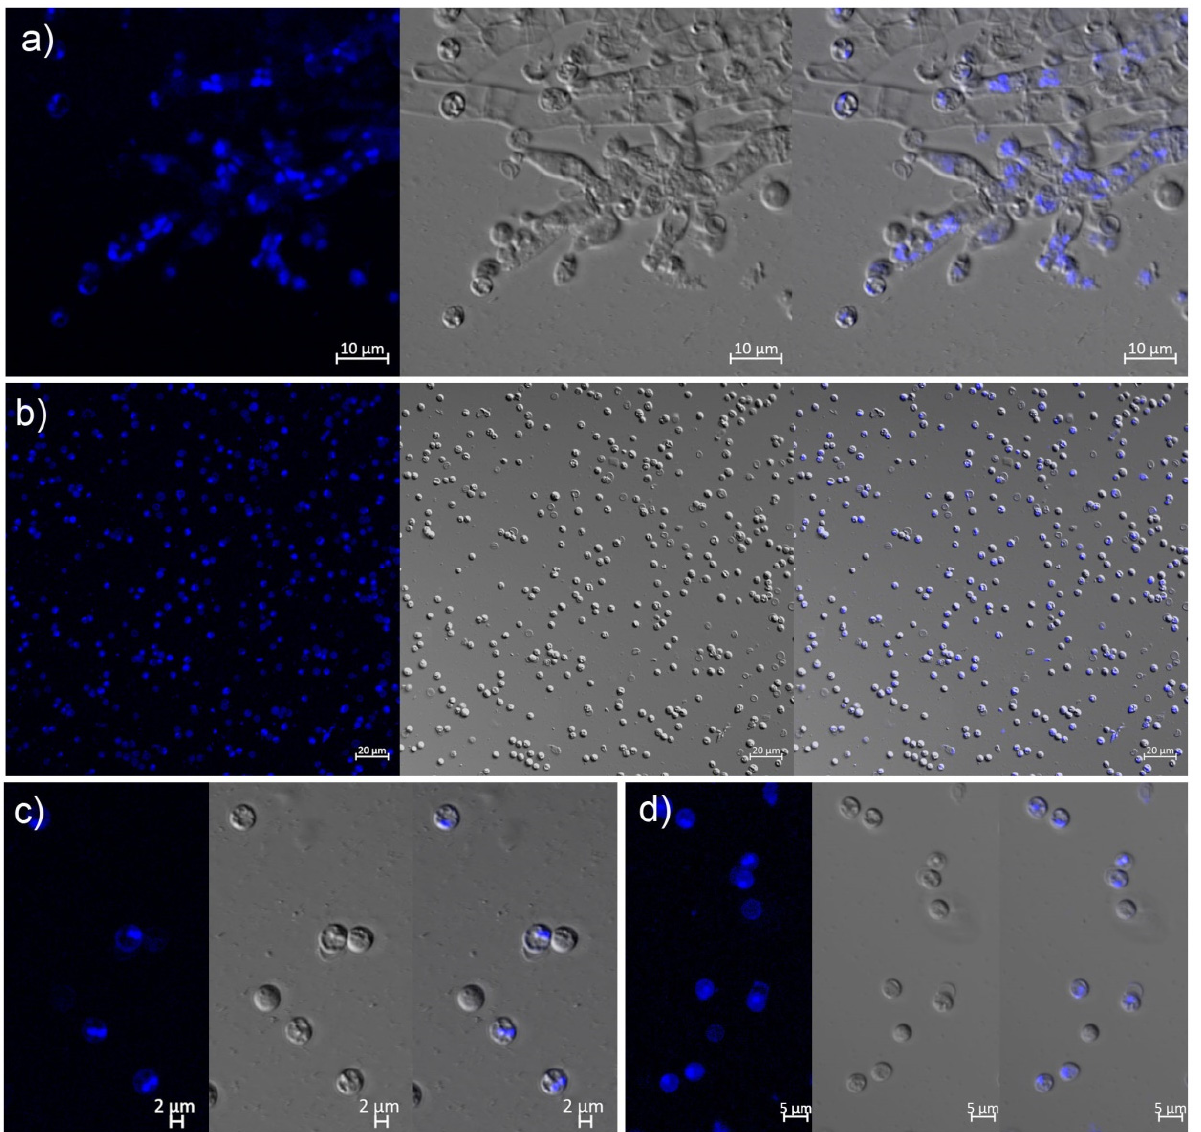
Figure 3. Morphological appearance of morel mitospores under laser confocal microscopy. ( a ) Mi- tospores growing from phialides supported by metulae. ( b ) Mitospores masses showing abundant mononucleate states. ( c , d ) Occurrence of bi- ( c ) and multinucleate ( d ) mitospores.